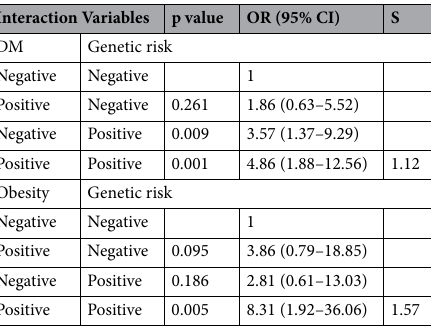
Interaction Variables p value OR (95%